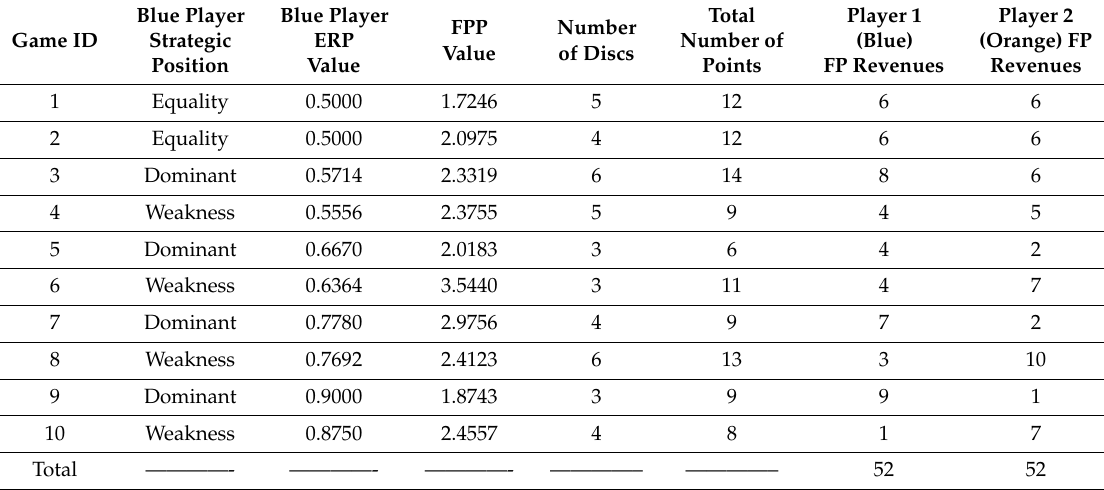
Table A1. Predefined game set